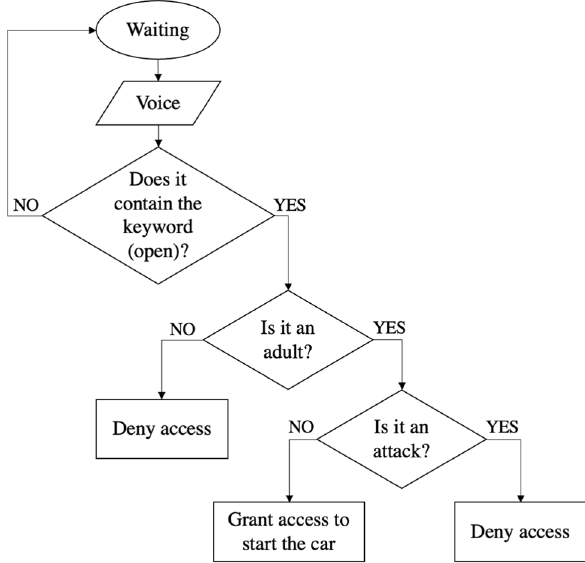
Fig. 1 Flowchart of robust speech recognition in